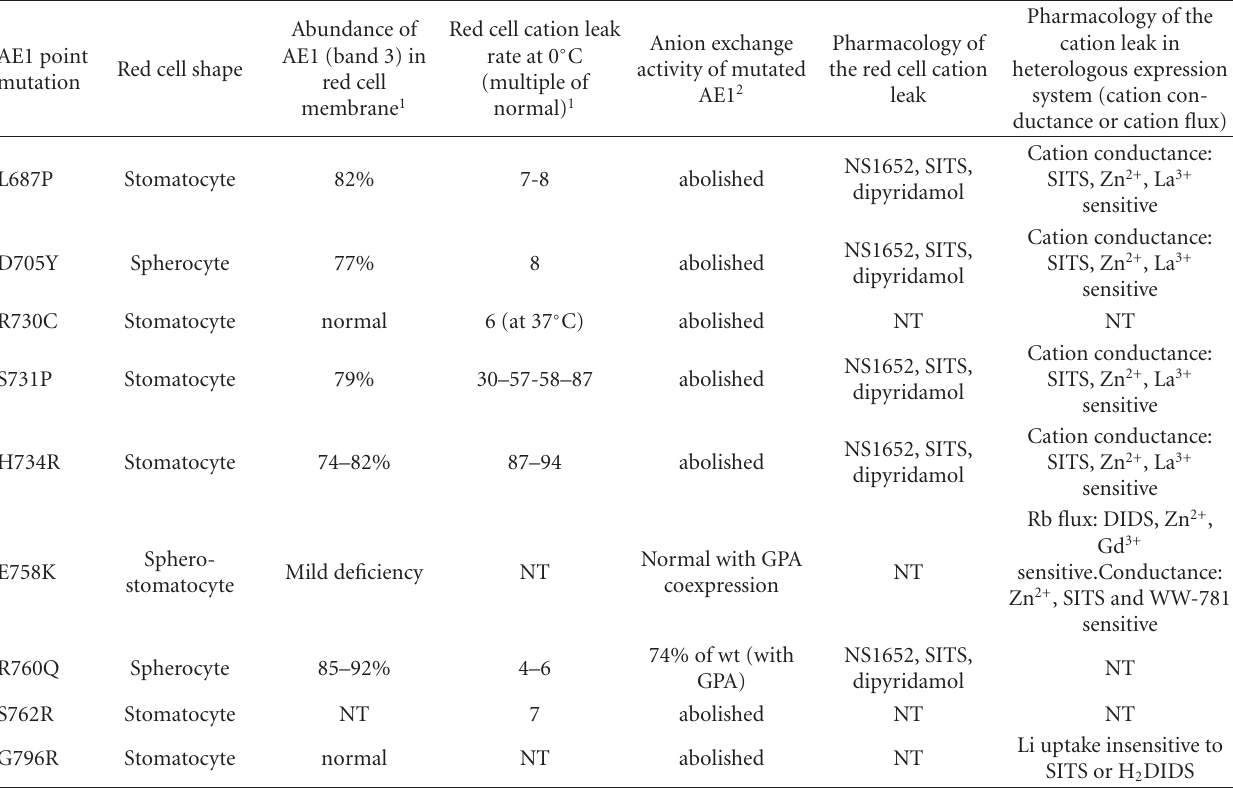
Table 1: Features of cation leaky red cells and point mutated